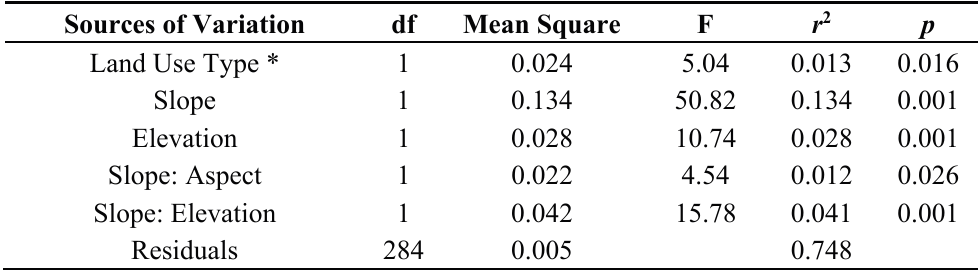
Table 1. Results from the PerMANOVA of the distance matrix constucted from LiDAR-derived forest